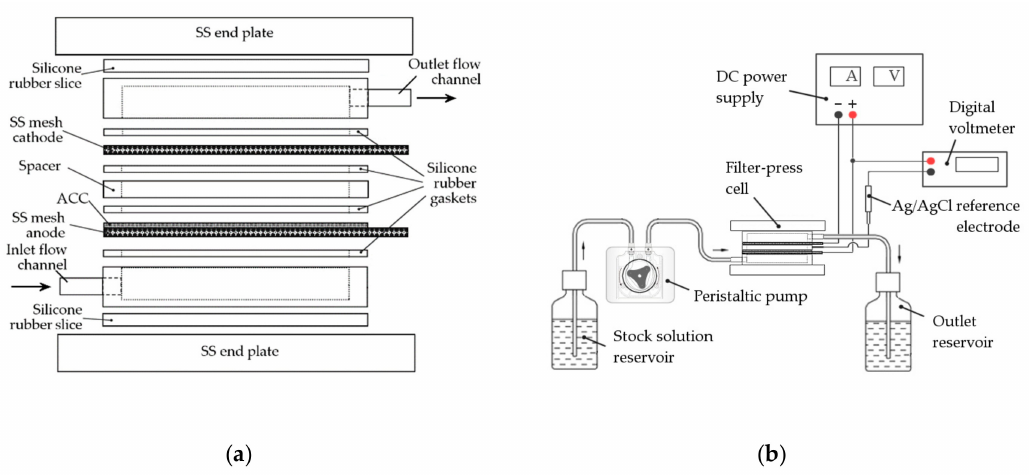
Figure 1. ( a ) Cut-away view of the electrochemical filter-press cell; ( b ) Schematic diagram of the electropolymerization